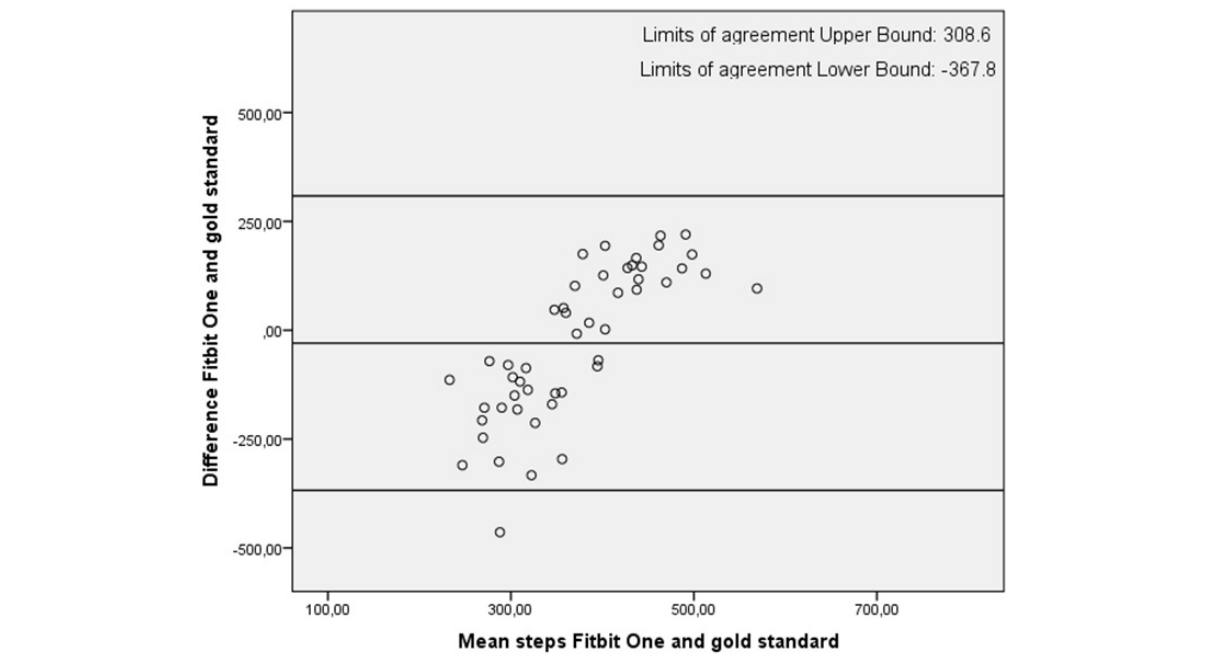
Figure 4. Bland-Altman plot of Fitbit One and the gold